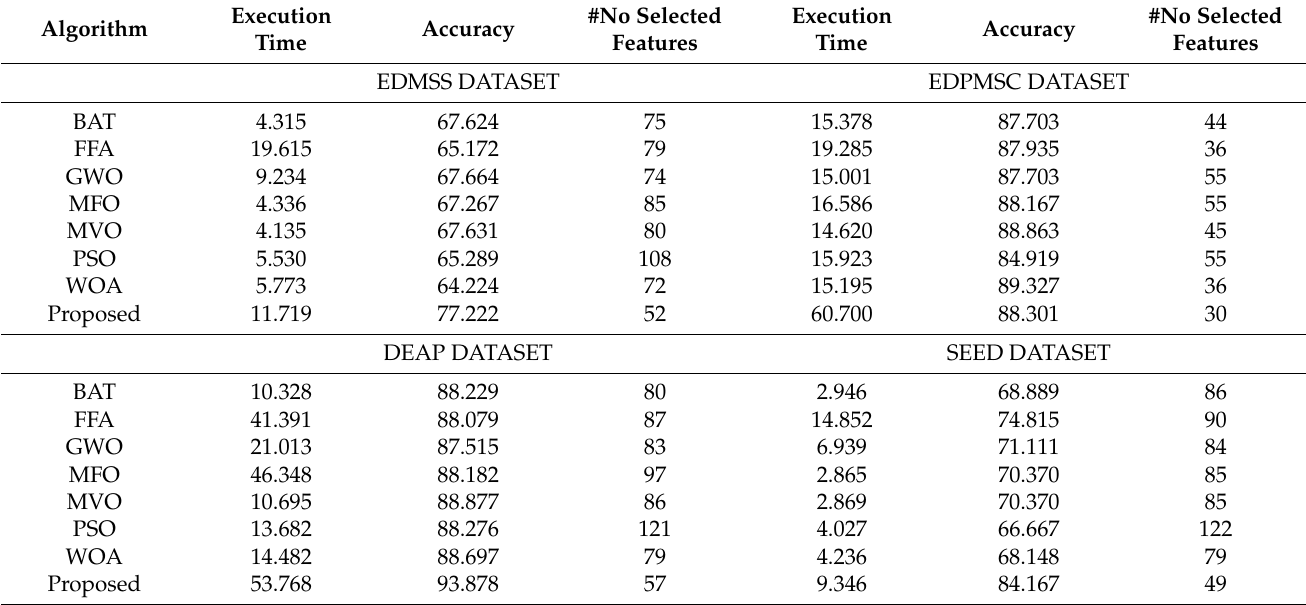
Figure 6. The evaluation performance of the proposed mRMR-PSO-SVM on different EEG datasets for mental stress detection. Table 3. The average values of the statistical parameters of classifiers using the subject independent